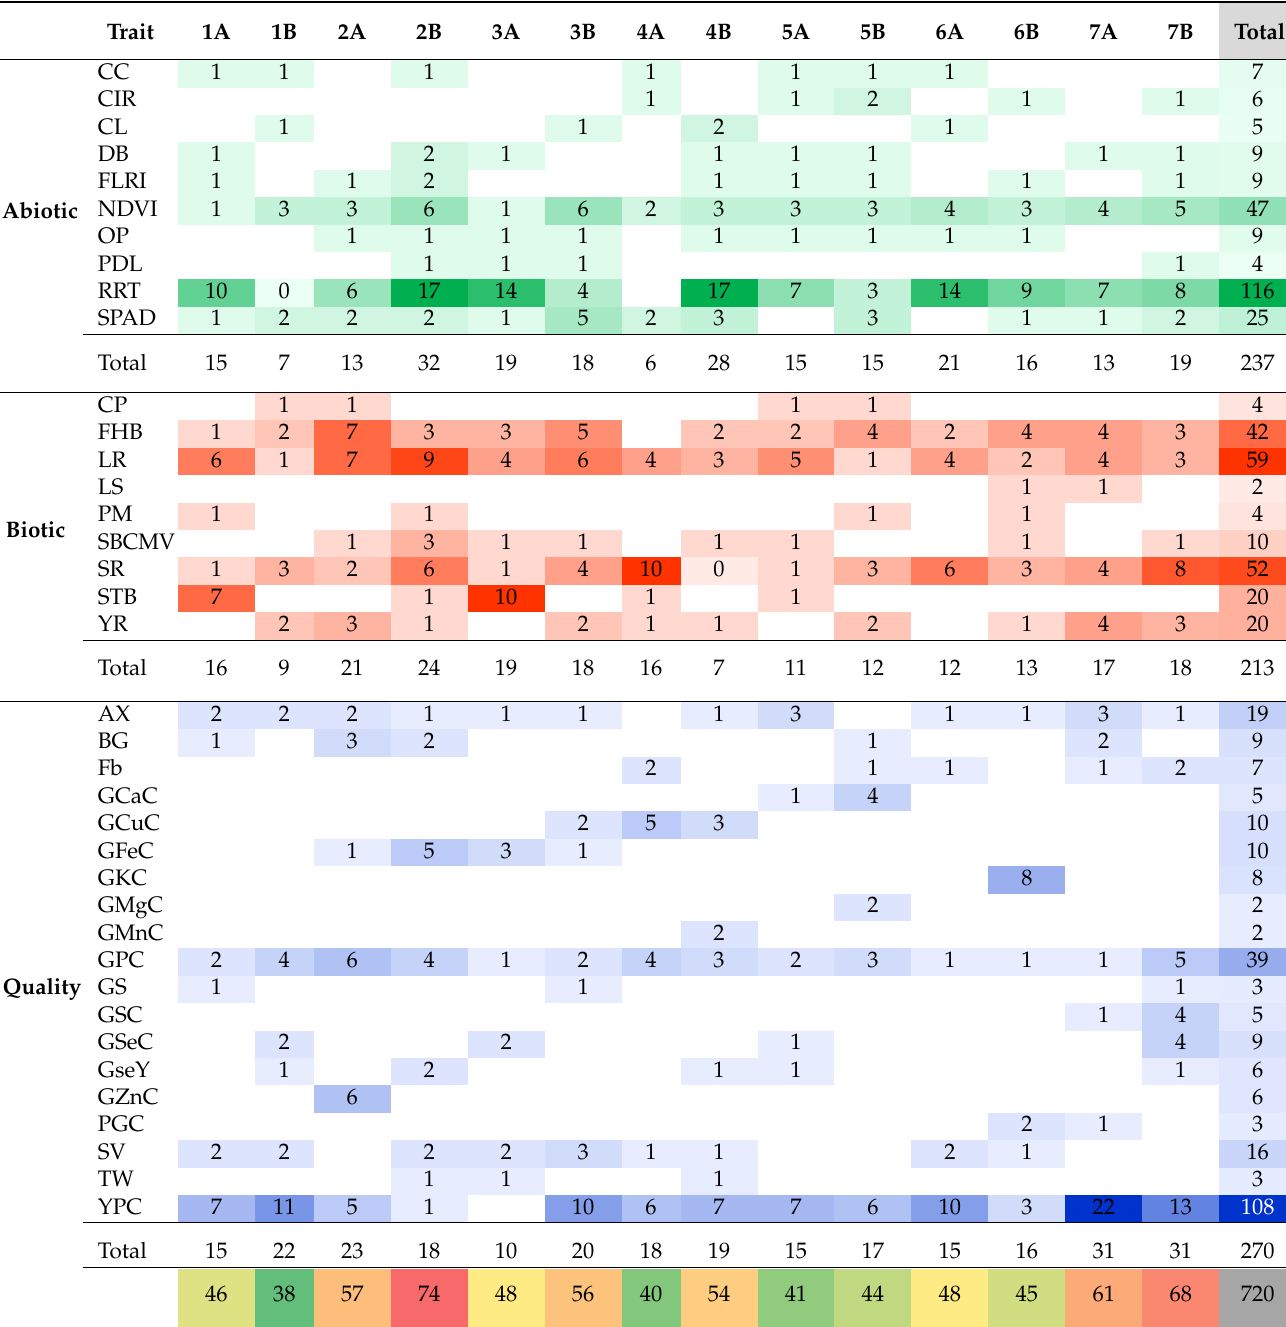
Table 4. The number of QTL per single trait and chromosome.